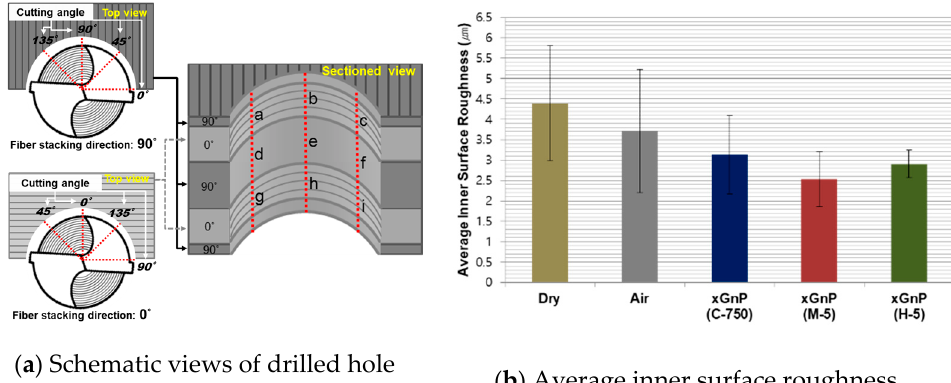
Figure 13. Schematic views of drilled hole and nine sectors and average inner surface roughness.